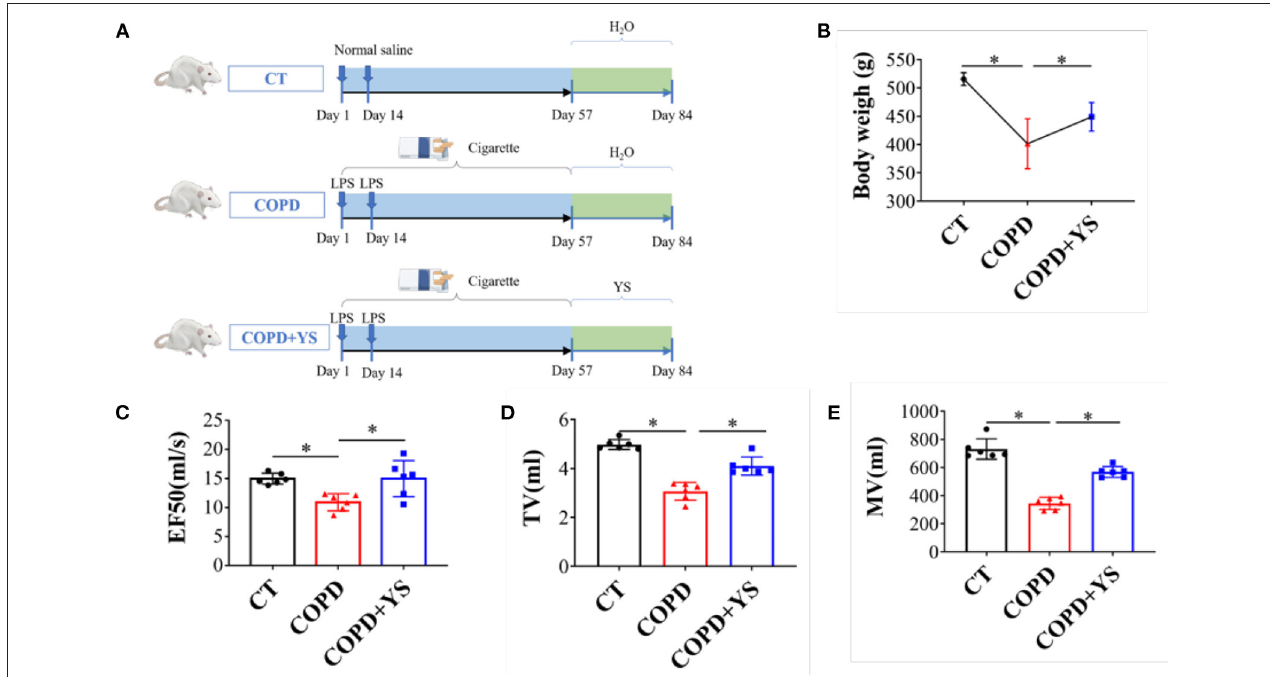
FIGURE 2 | (A) Timeline diagrams of the experimental design ( n = 6). (B) Body weight of the three groups including CT, COPD, and COPD + YS ( n = 6). (C) EF50 of CT, COPD, and COPD + YS ( n = 6). (D) TV of CT, COPD and COPD + YS ( n = 6). (E) MV of CT, COPD and COPD + YS ( n = 6). The data are presented as the means ± SEM of three experiments (* P <